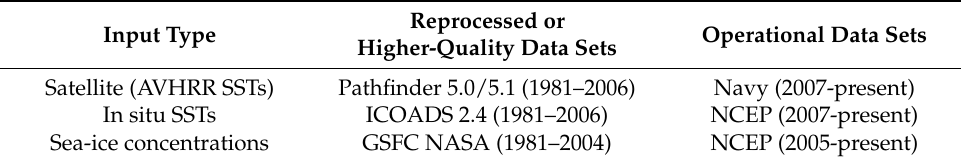
Figure 6. Mean mesoscale SST variance distribution derived from OI.v2-AVHRR-only data during the periods of ( a ) 1993–2016, ( b ) 2007–2018, and ( c ) 2007–2018 minus 1993–2016. Table 1. Input datasets to the daily OISST data. From [60].